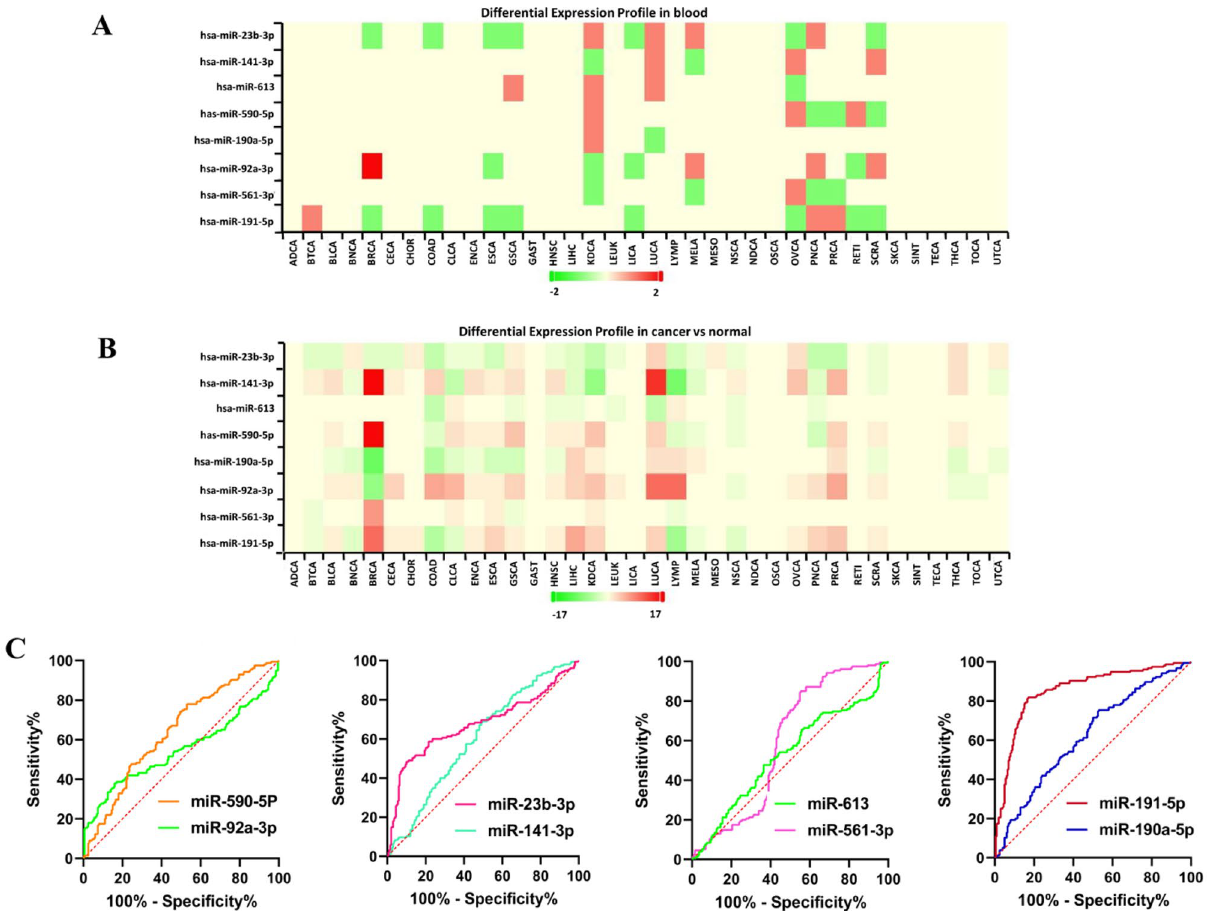
Figure 2. ( A ) The differential expression meta-profiling heatmap of the eight candidate biomarkers, in blood samples of cancer patients and healthy controls, across multiple cancer types. MiR-23b-3p, miR-92a-3p and miR-191-5p show significant expression differences in blood samples of BC patients and healthy controls. ( B ) The differential expression meta-profiling heatmap of the eight candidate biomarkers, in tissue samples of cancer patients and healthy controls, across multiple cancer types. MiR-141-3p, miR-590-5p and miR-190a-5p show significant expression differences in tissue samples of BC patients and healthy controls. BRCA breast cancer ( C ) The ROC curves for the 8 predicted miRNA biomarkers. miRNAs Area Std. error 95% Confidence interval P